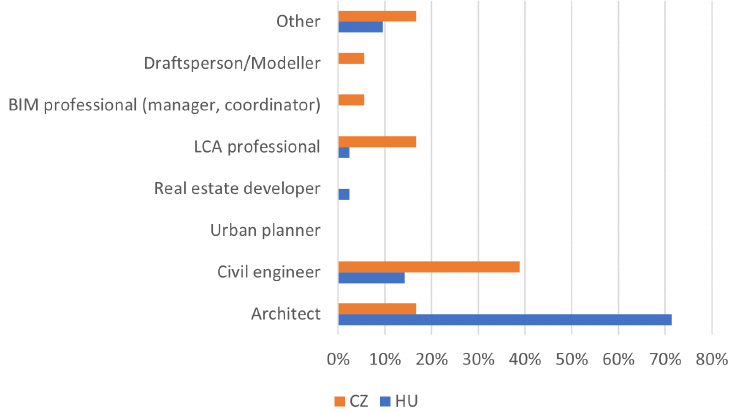
Figure 1. Occupation of respondents (based on 42 (HU) + 18 (CZ) = 60 responses).